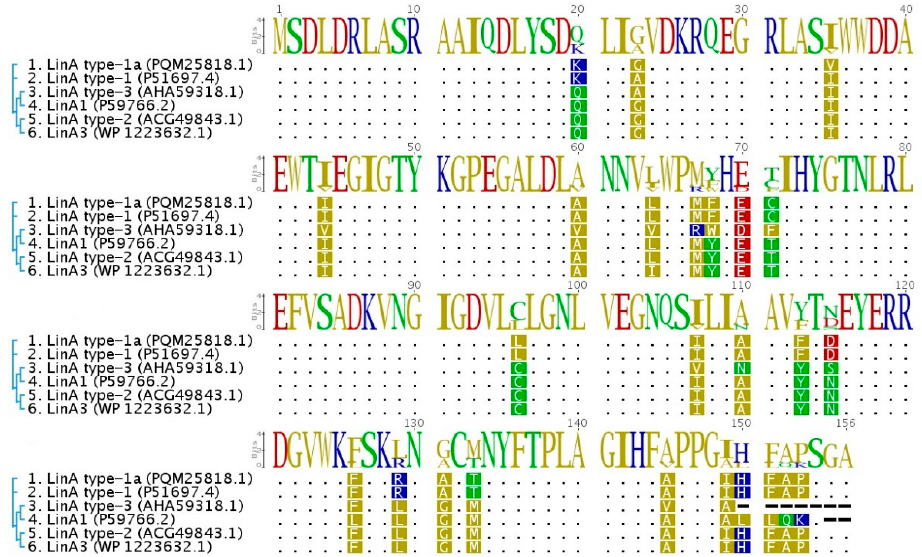
Figure 4. Multiple sequence alignment of LinA protein variants. The amino acid sequence of LinA type-1a from WS5A3p strain (1) compared to previously known variants of this protein (LinA type-1 from Sphingobium japonicum UT26 (2), LinA1 from Sphingobium indicum B90A (4), LinA3 from Sphingobium sp. HDIPO4 (6), LinA type-2 (5) and LinA type-3 from soil metagenomes (3)). Sequences were aligned and visualized using Geneious [27]. Dots correspond to the identical amino acids, dashes indicate the gaps. Phylogenetic relationships are indicated next to the sequence names and accession numbers.